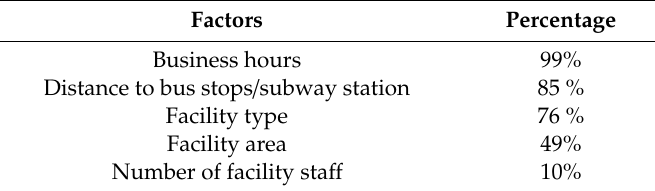
Table 2. Resident preferences survey: factors a ff ecting the attractiveness of the facility.